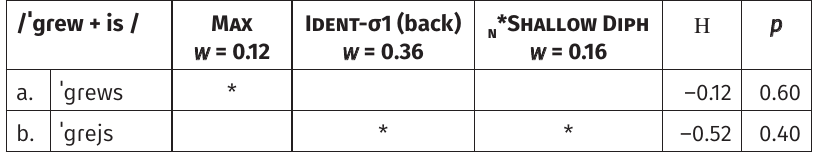
Table 7: Children 7–9 y/o: a preference for the faithful plural in monosyllables. /ˈɡɾew + is